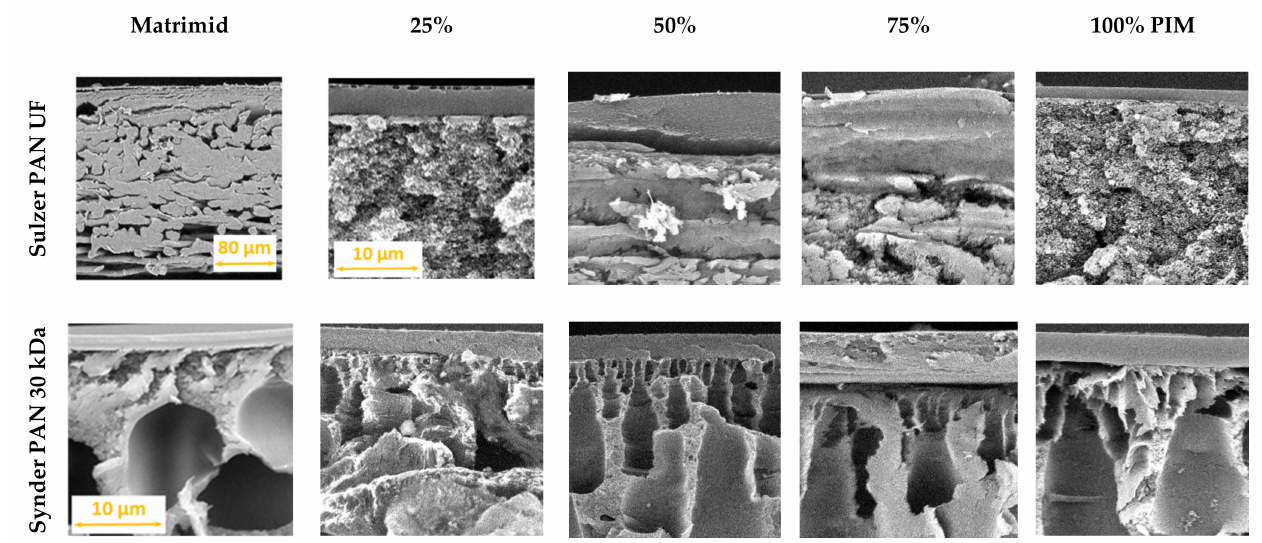
Figure 4. Cross-sectional SEM images of the Matrimid ® 5218/PIM-EA(Me 2 )-TB blend membranes with different blend compositions on a Sulzer PAN UF membrane support (top) and a Synder PAN 30 kDa porous membrane support (bottom). Magnification 5000 × and electron acceleration voltage 10 kV. The scale bar is 10 µ m for all samples, with the exception of the TFC of Matrimid on Sulzer PAN. The presence of the neat PIM-EA(Me 2 )-TB coating layer on the porous PAN support was confirmed by the FTIR analysis of the composite membrane (Figure